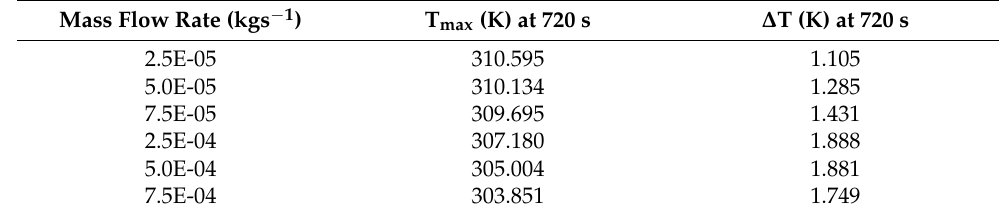
Table 3. Influence of mass flow rate at 720 s–LCD.